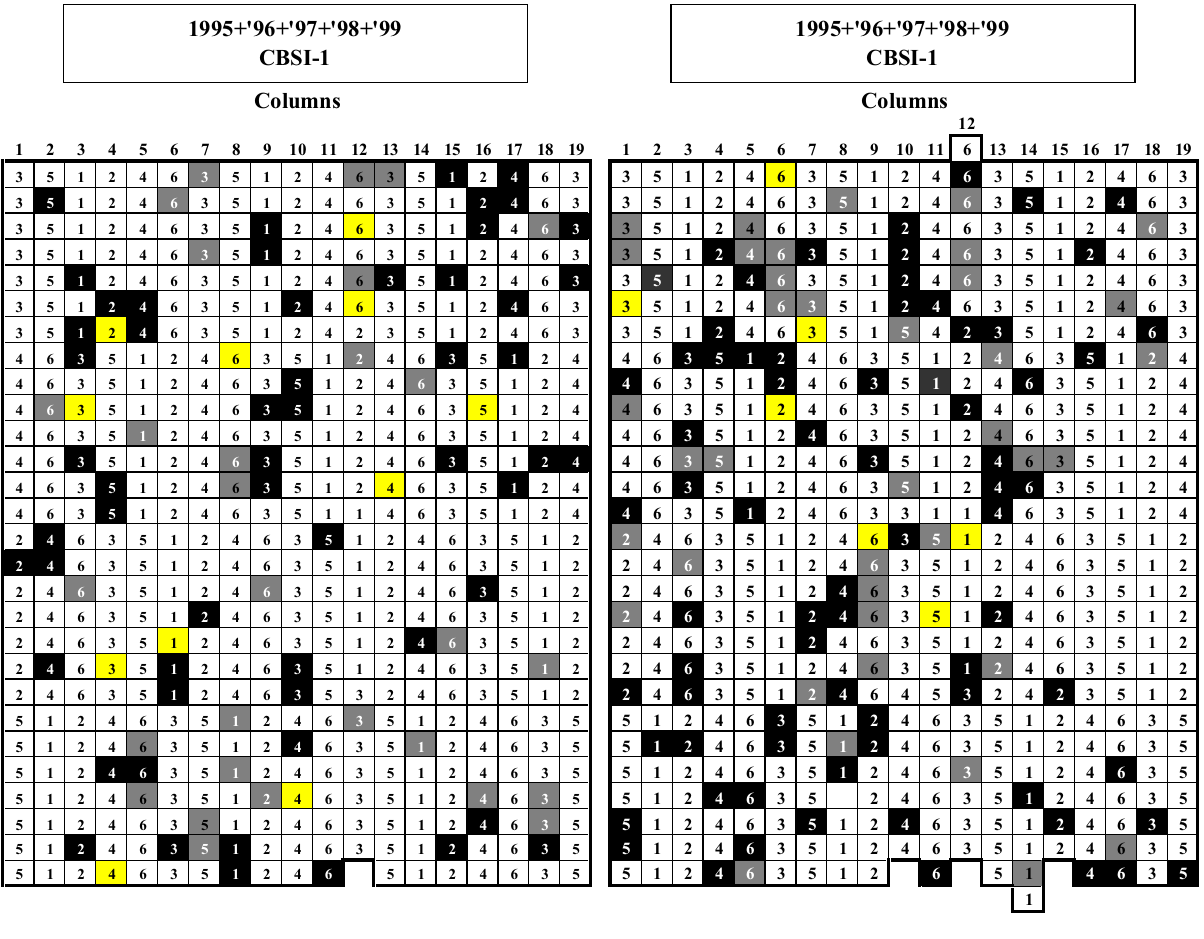
Fig. 1. Spatial distribution of vines in vineyards CBSI-1 (cv. Sangiovese) and CBSI-2 (cv. Trebbiano) on six root- stocks: 1. 140R; 2. 1103P; 3. K5BB; 4. 320A; 5. SO 4; 6. cv. Vitis vinifera own-rooted. 0 = Plants exhibiting only chronic symptoms; 0 = plants with apoplexy; 0 = plants that did not revegetate after winter and whose woody tissue presented signs of esca infection; = healthy plants; 0 = plants missing before